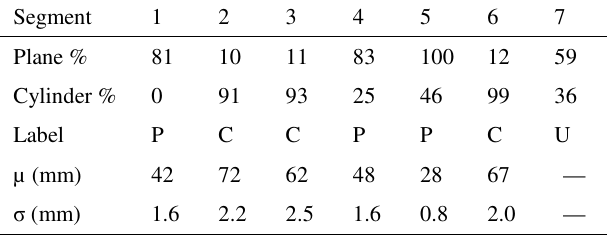
Table 1: Real-world point cloud. Percentage of inliers adjusted for each model, mean distance (µ) and standard deviation ( σ ).